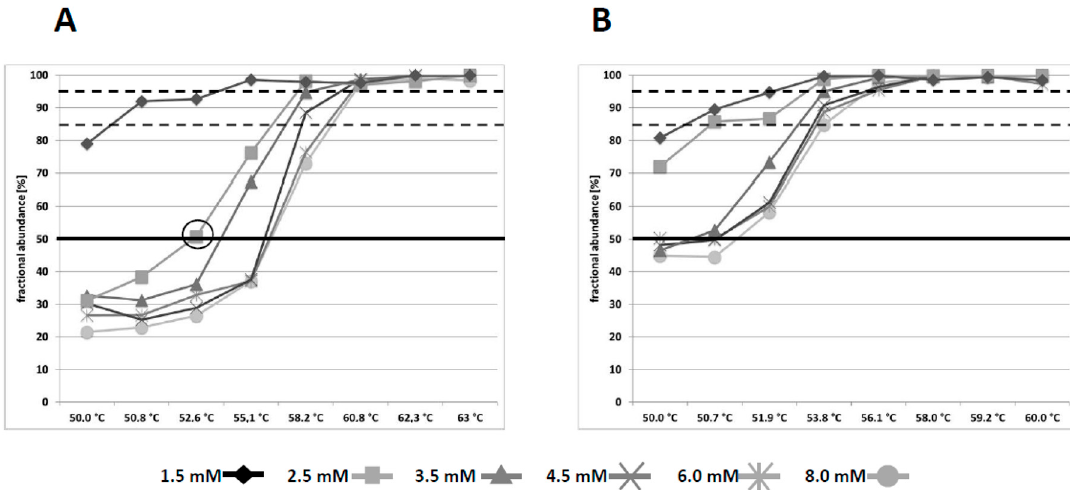
Figure 1. Analyses of RASSF1A and GSTP1 PCR bias depending on pre-amplification conditions. Custom DNA standards were established comprising 150 copies of methylated and 150 copies of unmethylated DNA fragments for GSTP1 and RASSF1A . The impact of varying magnesium chloride concentrations (1.5–8.0 mM) and annealing temperatures (50–63 ◦ C) on the amplification efficiency of methylated and unmethylated RASSF1A ( A ) and GSTP1 ( B ) template DNA was measured after 15 PCR pre-amplification cycles by subsequent ddPCR analysis. The percentages of methylated DNA fragments relative to the sum of all detected target sequences (fractional abundance) are